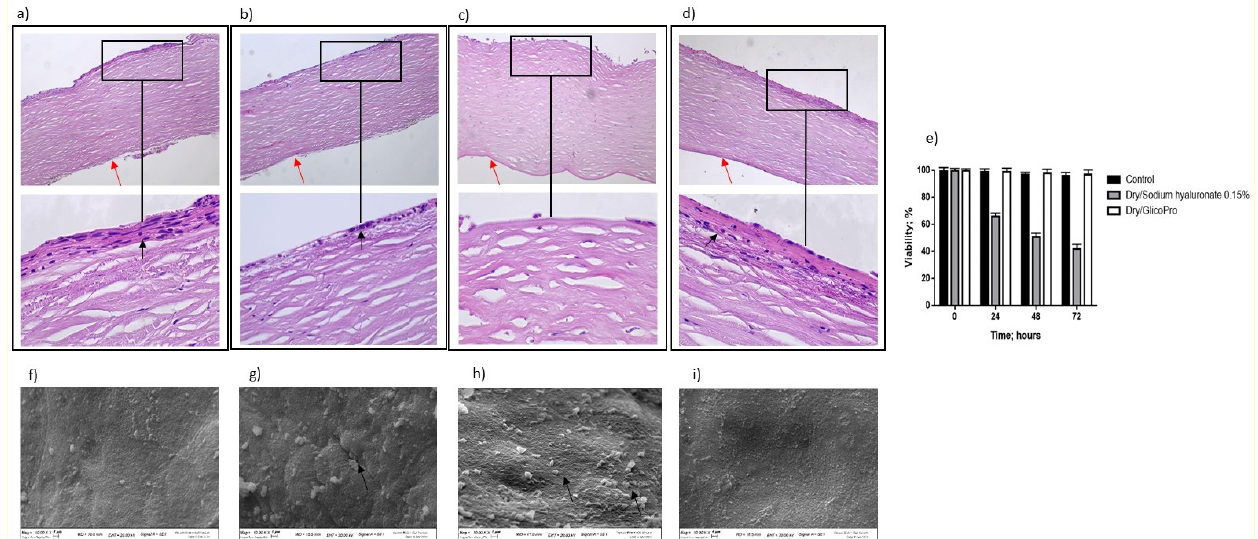
Figure 2. Histo-morphological analysis. Histo-morphological analysis of ( a ) control group corneal tissues; ( b ) dry eye; ( c ) control dry eye (100 µL sodium hyaluronate 0.15%), and ( d ) dry eye corneal tissues treated with GlicoPro for 24 h. Magnifications: 10 × (upper panels), 60 × (lower panel). Red arrows indicated endothelial cell layer; black arrows indicated stratified squamous epithelium. ( e ) Cell viability assessed by trypan blue staining. Scanning electron microscopy images of human corneal tissue in ( f ) control; ( g ) dry eye; ( h ) control dry eye (100 µL sodium hyaluronate 0.15%); and ( i ) GlicoPro- treated dry eye conditions. Each condition was analyzed in triplicate. Scale bars = 100 µm.